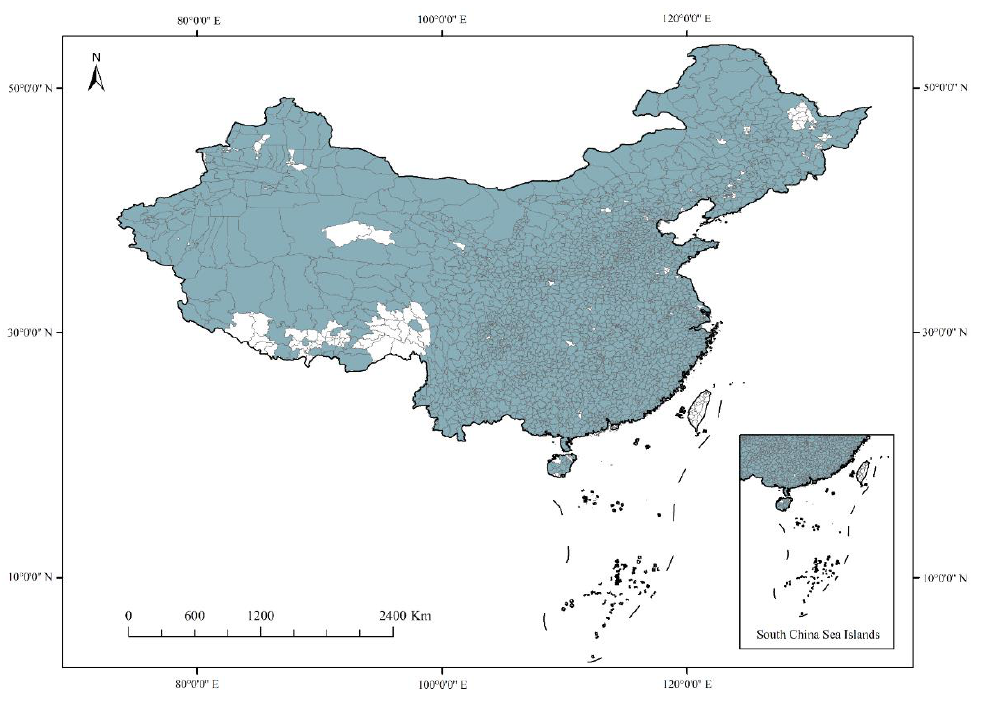
Figure 1. County-level spatial units in China (no GDP data if blank).